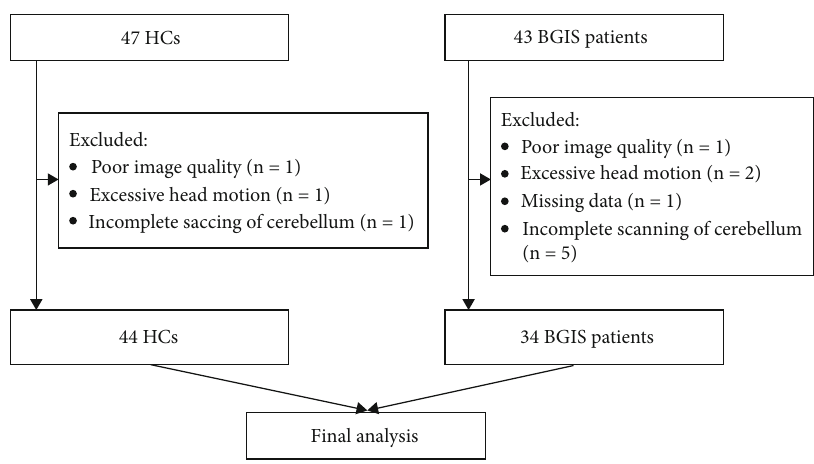
Figure 1: Flow chart. HCs: healthy controls; BGIS: basal ganglia ischemic stroke. Table 1: Demographic and clinical characteristics of the